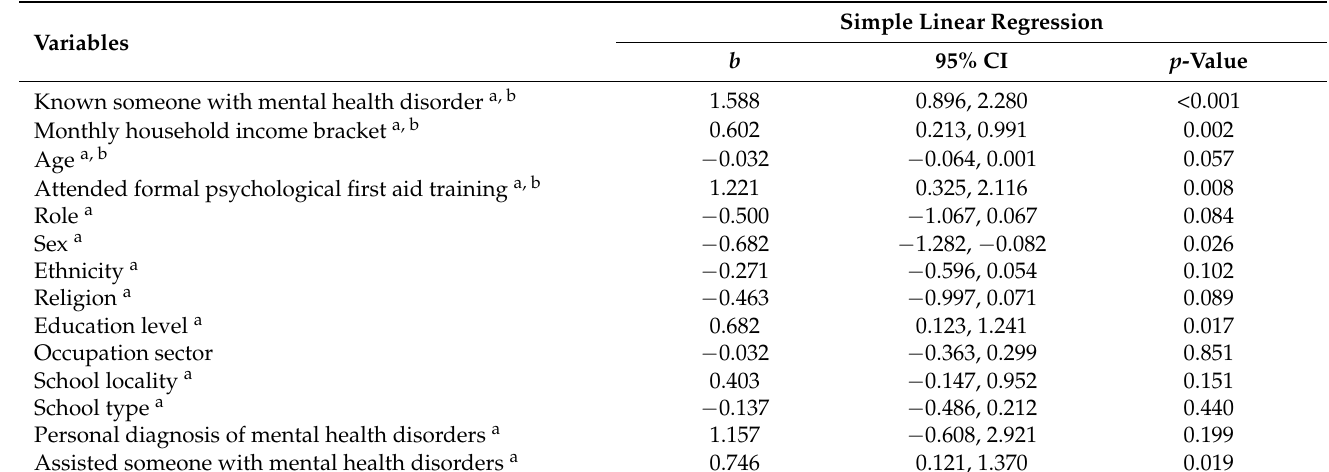
Table 3. Simple linear regression of mean score of MAKS-M among parents, guardians, and teachers of adolescents in West Malaysia (n =